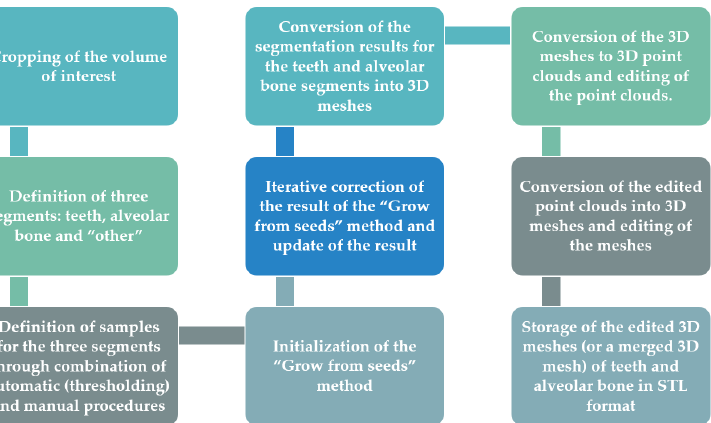
Figure 20. Proposed methodology for 3D modeling of the hard tissues of the oral system using dental CBCT data.